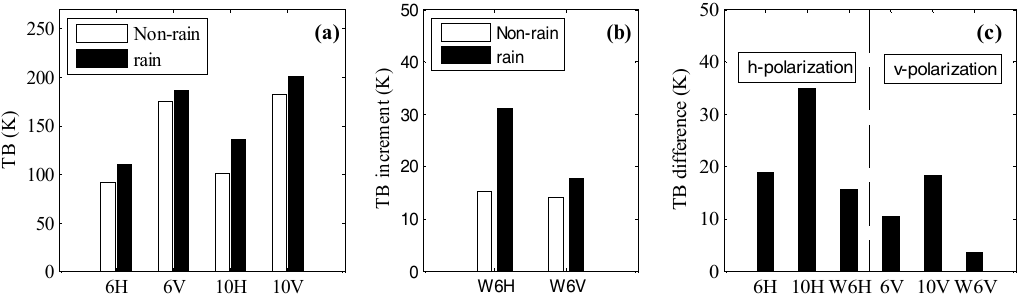
Figure 9. Comparison of radiance characteristics for rain area and non-rain area over hurricane Bill on 19 August 2009, at 1650 to 1654 UTC. ( a ) Average brightness temperature value of each selected channel; ( b ) average brightness temperature increment of W6H (W6V); and ( c ) brightness temperature difference caused by rain.